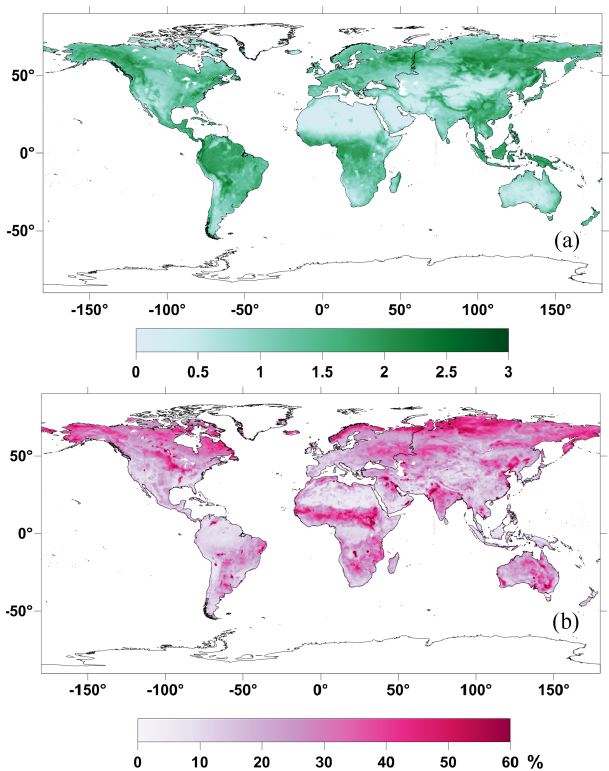
Figure 7. Annual mean (a) and 2 times the coefficient of varia- tion (b) of LPDR 25km global X-band VOD daily estimates from AMSR-E/2 ascending observations encompassing the years 2003– 2010 and